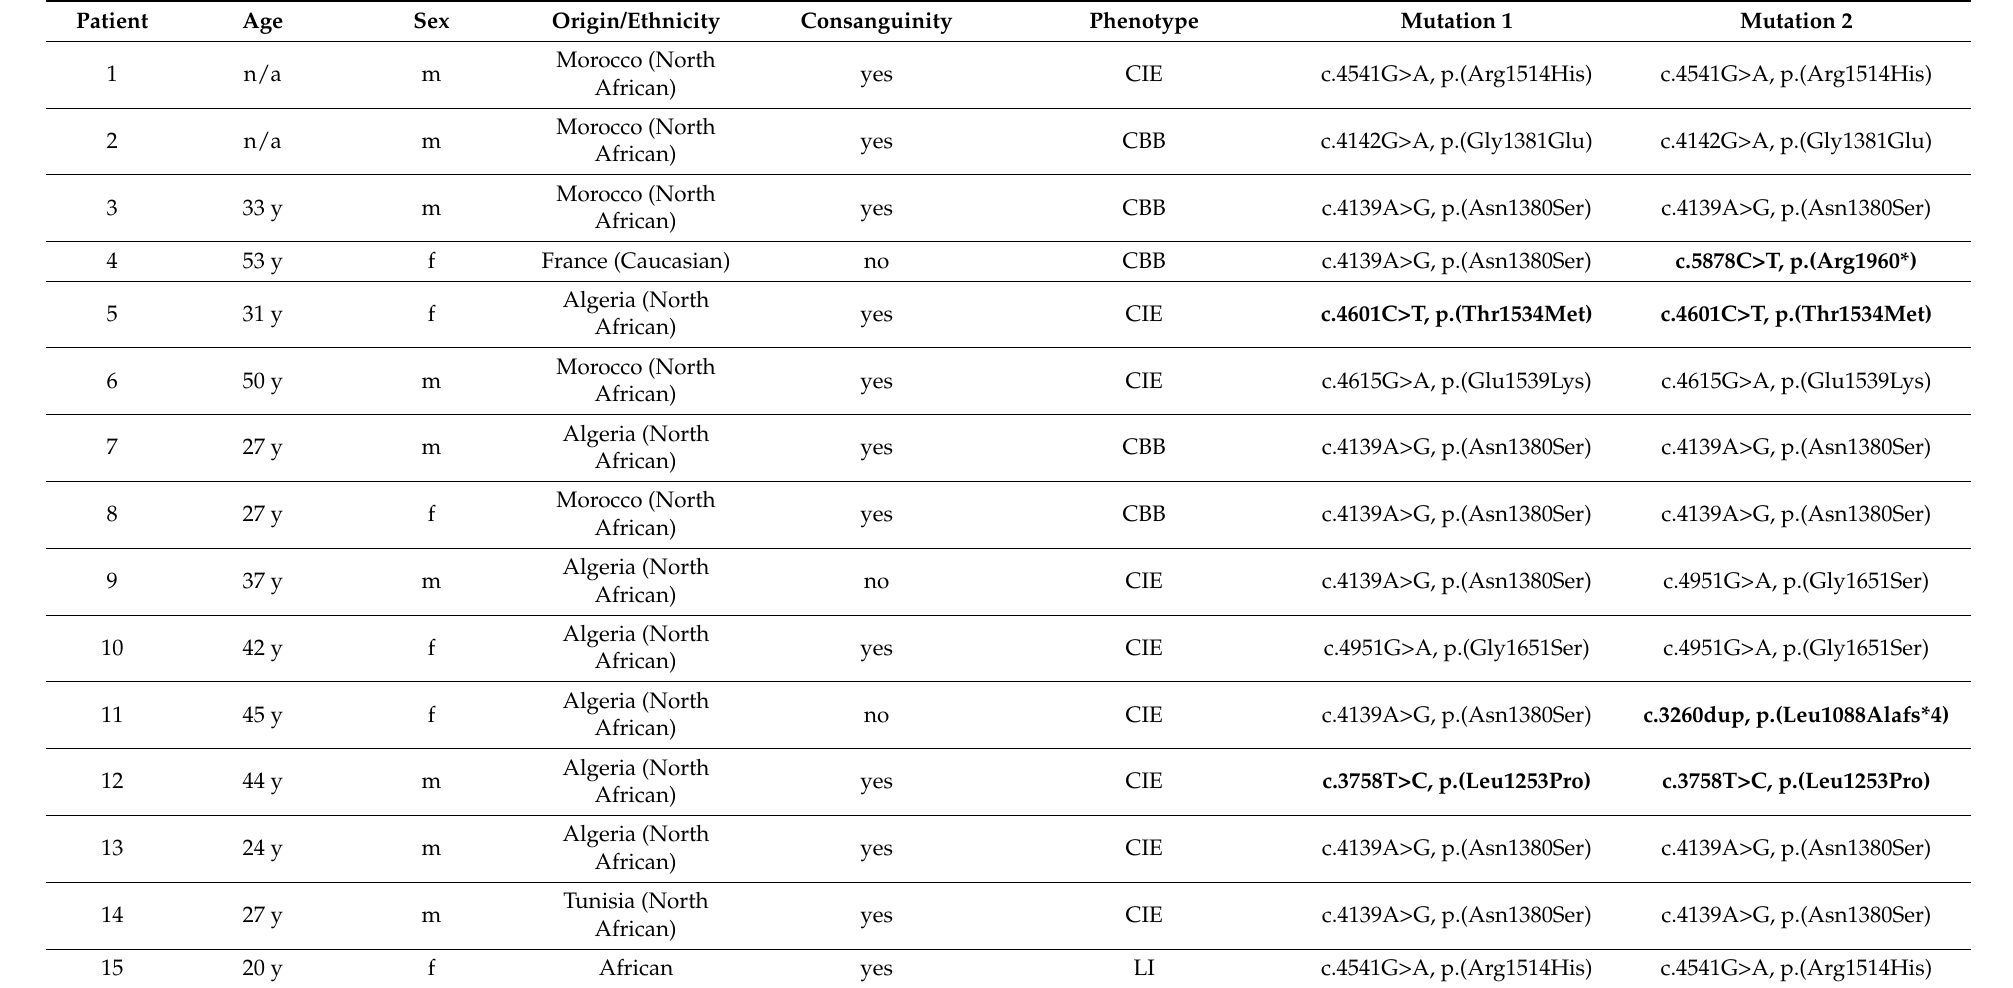
Table 1. Identified mutations in ABCA12 in patients with